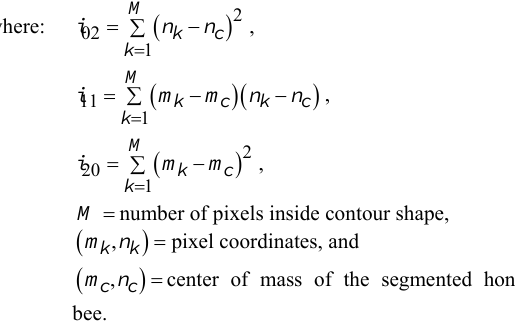
N  σ mean color variance of honey bees that do not have pollen load estimated from all previous video frames including training data set, P N  number of pollen bearing honey bees in all previous video frames including training data set, load in all previous video frames including training data